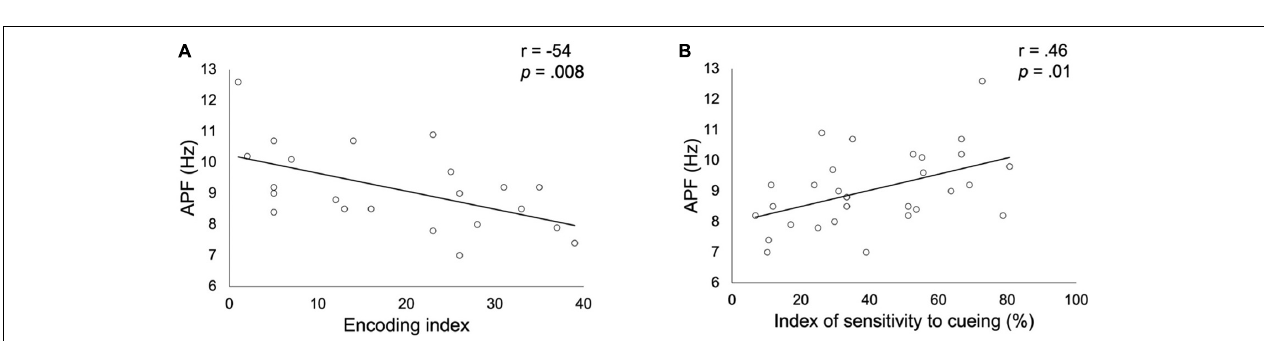
FIGURE 1 | Difference in regional glucose consumption between patients with altered FCSRT performance and healthy elders. Statistical parametric maps were built as T contrasts evaluated at each voxel of the FDG-PET data while controlling for age, gender and years of education. These maps show a significant reduction in regional glucose consumption in patients with altered FCSRT performance compared with healthy elders. Images are thresholded at p < 0.05, FWE-corrected with a cluster threshold at 100 voxels for visualization purpose. The color scales on the left represent the T-statistic of the significant voxels.